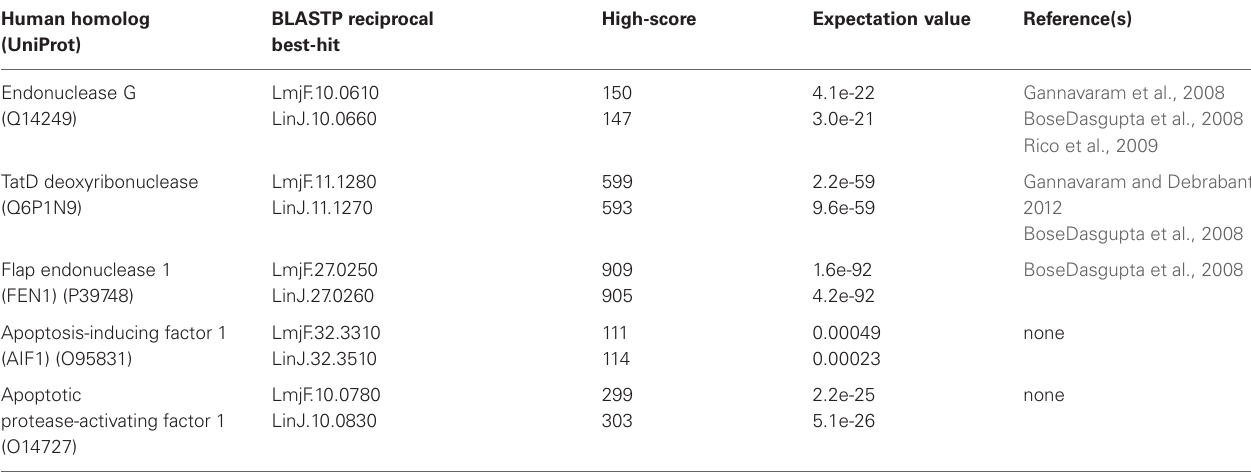
Table 1 | We searched the literature and conducted BLASTP homology searches, followed by reciprocal best-hit analysis, to assemble a list of Leishmania homologs of the putative regulators or effectors of